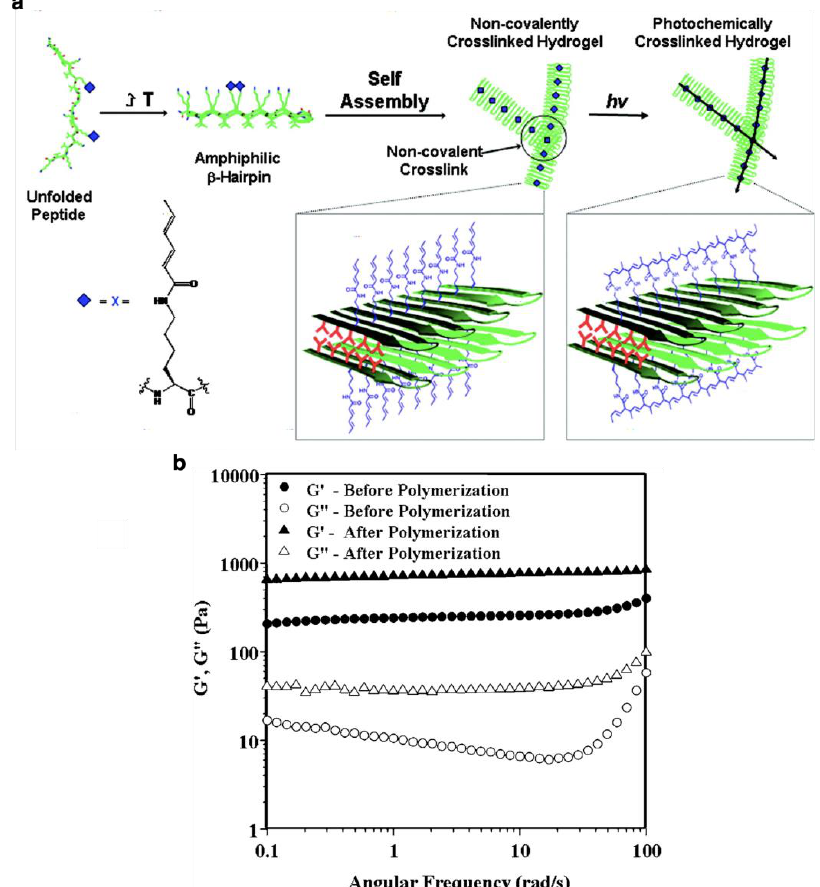
Figure 4. ( a ) Proposed mechanism of folding of photopolymerizable β -hairpin peptide fibers and their self-assembly leading to hydrogelation and the subsequent photopolymerization of its fibrillar network. ( b ) Rheological properties of the β -hairpin peptide fiber hydrogels before and after polymerization. Reprinted with permission from ref 67. Copyright 2010 American Chemical Society.